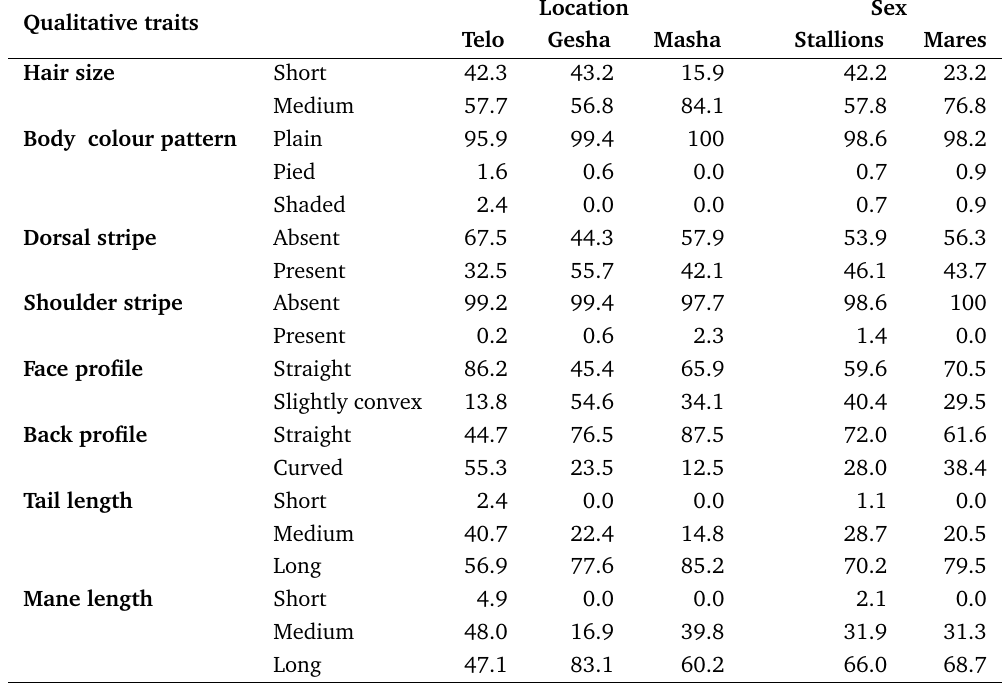
Table 16. Percentages of qualitative traits of the horses (both sexes) from different locations. Qualitative traits